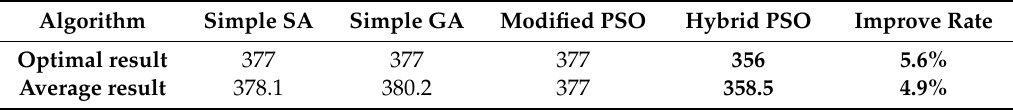
Table 5. The result comparison of di ff erent algorithms in case